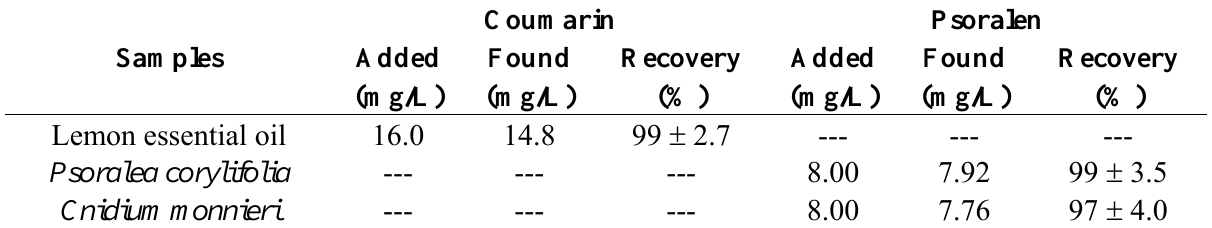
Table 2. Recoveries of coumarins in essential oil and traditional Chinese herbal medicines using differential pulse voltammetry (DPV).